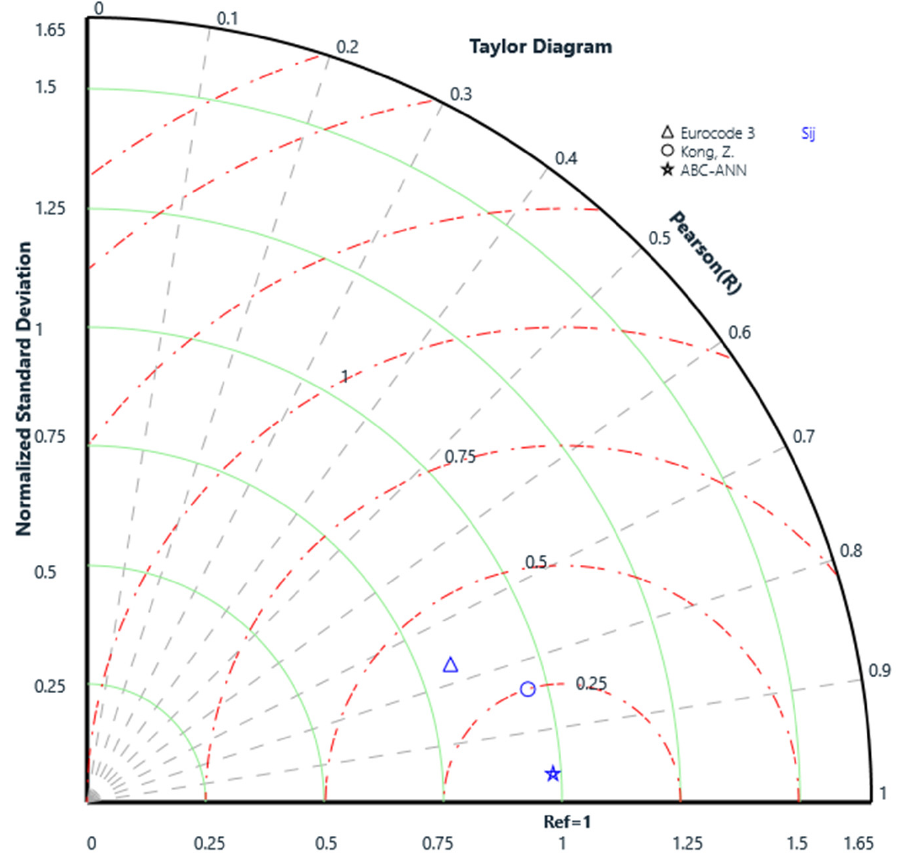
Figure 10. Taylor diagram visualization of model performance, in terms of S j,ini predictions.